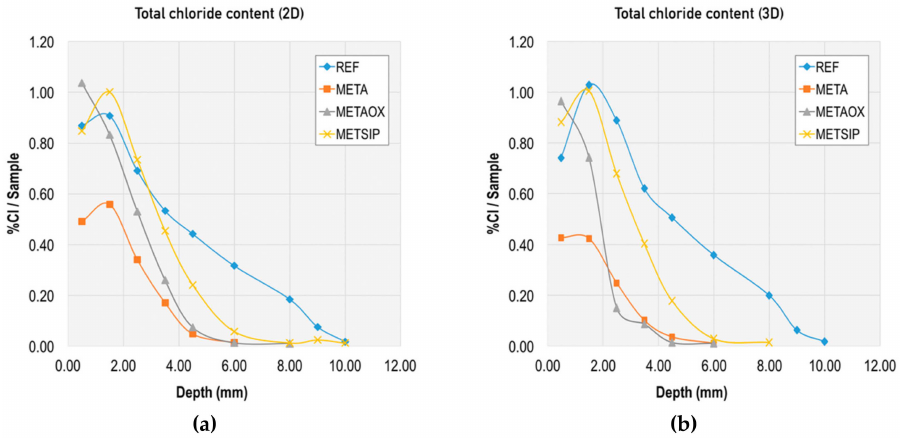
Figure 10. Total chloride content in di ff erent mixes at early ages: ( a ) at two days and ( b ) at three